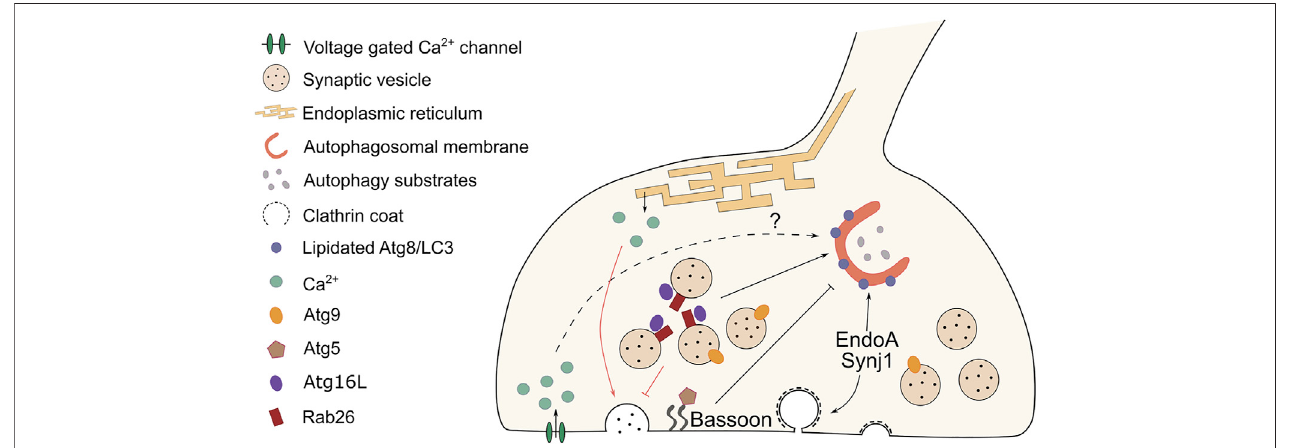
FIGURE 1 | Cross-regulation between autophagy and synaptic vesicle cycling at the pre-synaptic terminal. At synapses, synaptic vesicle (SV) cycling and autophagyareinterconnectedandreciprocallyregulated.BlacklinesindicatetheeffectonautophagosomeformationelicitedbycomponentsoftheSVmachinery,while red lines highlight the in fl uence on neurotransmission evoked by changes in autophagy levels. The endocytic proteins EndoA and Synj1 participate in autophagosome formation respectively by recruiting ATG3 and by allowing ATG18 to cycle off the autophagosomal membranes. Both actions result in the lipidation of ATG8/LC3. The scaffold protein Bassoon has the opposite effect. It sequesters ATG5 and prevents autophagosome formation. Pre-synaptic calcium waves are associated with autophagy induction, but a direct mechanistic link between the two is missing. Cycling of ATG9-positive vesicles facilitate autophagosome formation at pre-synaptic sites.TheGTPaseRab26clustersonSVsandbyinteractingwithATG16LitrecruitstheautophagymachinerythatengulfsanddegradesSVs.SVturnovermodulatesthe strength of neurotransmission. Reduced numbers of SVs, due to autophagy-mediated clearance, results in decreased neurotransmitter release. An opposite effect is observed when autophagy is abolished and tubular ER accumulates at synapses. As a consequence, calcium buffering is altered and neurotransmission is enhanced. The crosstalk between synaptic autophagy and neurotransmission might represent a feedback mechanism that synapses employ to regulate both pathways in a fl exible way.